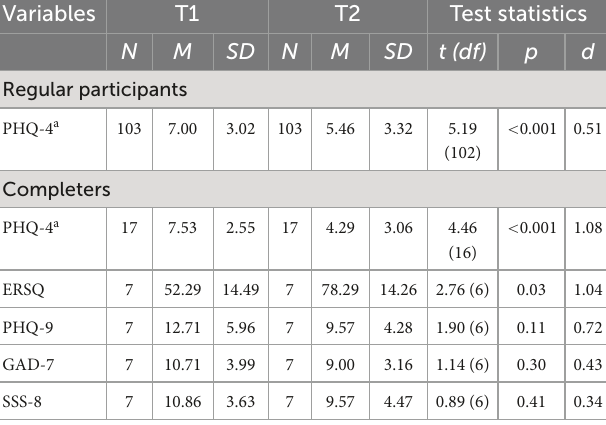
TABLE 4 Descriptive and test-statistics of the pre-post inner subject comparison of the primary and secondary outcomes.